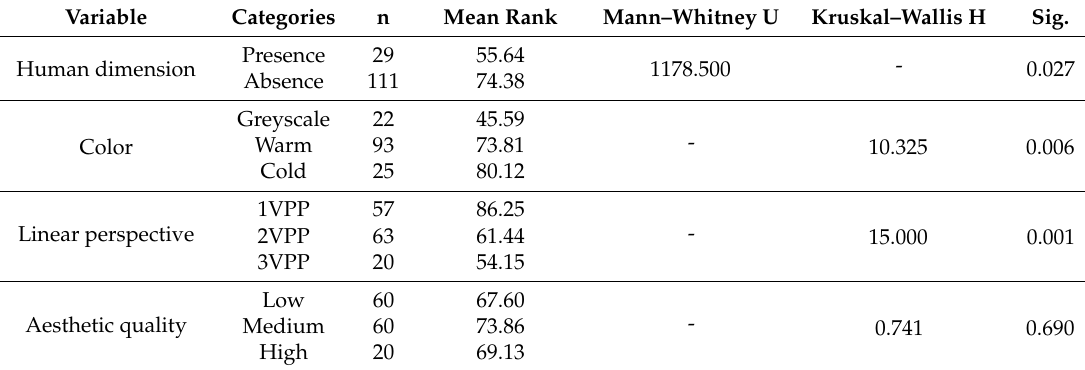
Table 2. Non-parametric test results (dependent variable: